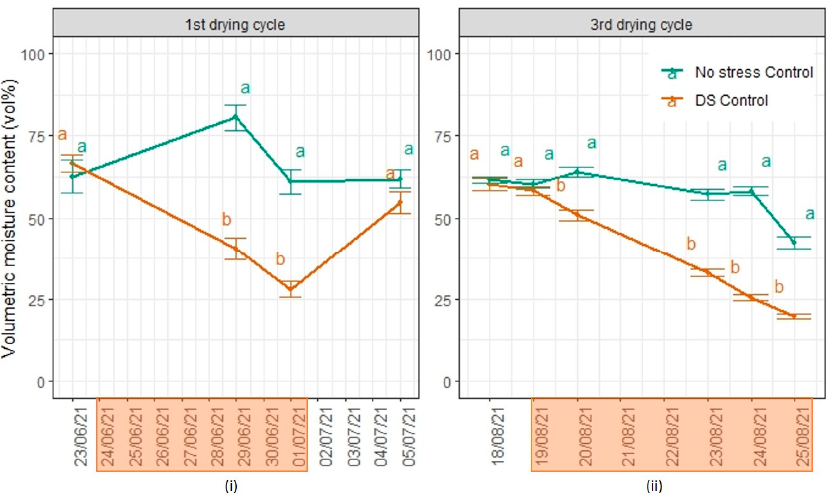
Figure 2. Effect of the drying cycles (DS Control) on the volumetric moisture content of the substrate of Hydrangea compared with optimal irrigation conditions (No stress Control). ( i ) first cycle: 23 June 2021–1 July 2021, ( ii ) third cycle: 19–25 August 2021. Highlighted dates indicate stress period. Treatments at 29 June 21, 1 July 2021, 5 July 2021, 19 August 2021, and 20 August 2021 were compared by